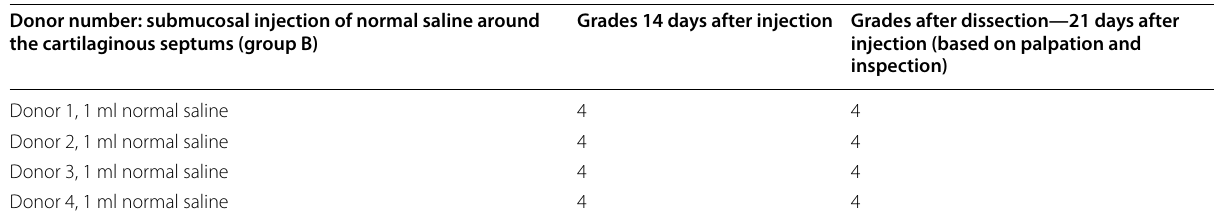
Table 3 Results in the control group (saline injection) Donor number: submucosal injection of normal saline around the cartilaginous septums (group B)